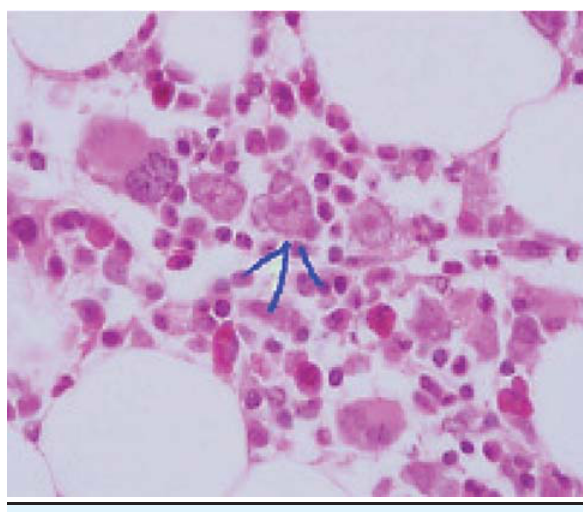
Figure 2. Trephine biopsy showing giantproerythroblasts with a megakaryocyte at the left hand end of the row Blood PCR for Parvo B19 virus was sent and serum was tested for the presence of IgM antibodies against Parvo B19 virus both tests were reported as positive.